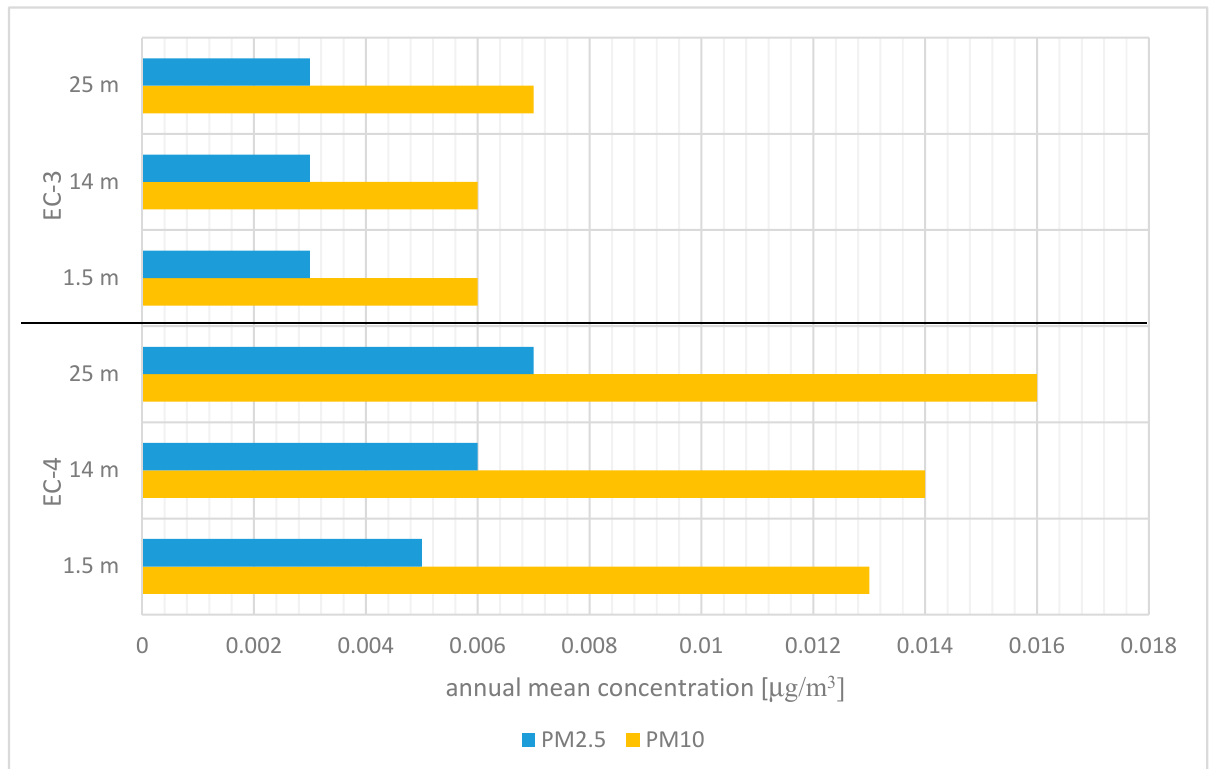
Figure 4. The highest annual average concentration of particulate matter pollutants at the height of 1.5, 14, and 25 m for the EC-3 and EC-4 CHP plants based on the results from OPA03.